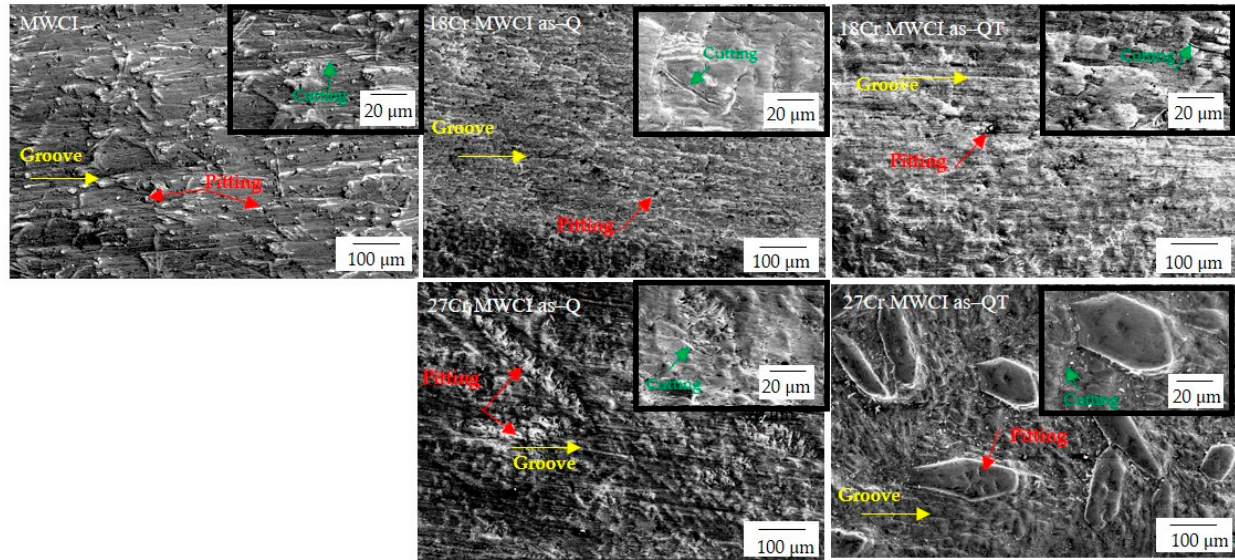
Figure 10. The worn surface of materials after test with the highest applied